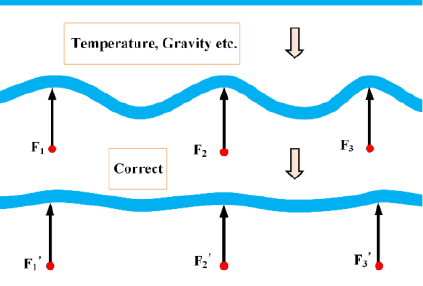
Figure 3. Schematic diagram of the calibration process.